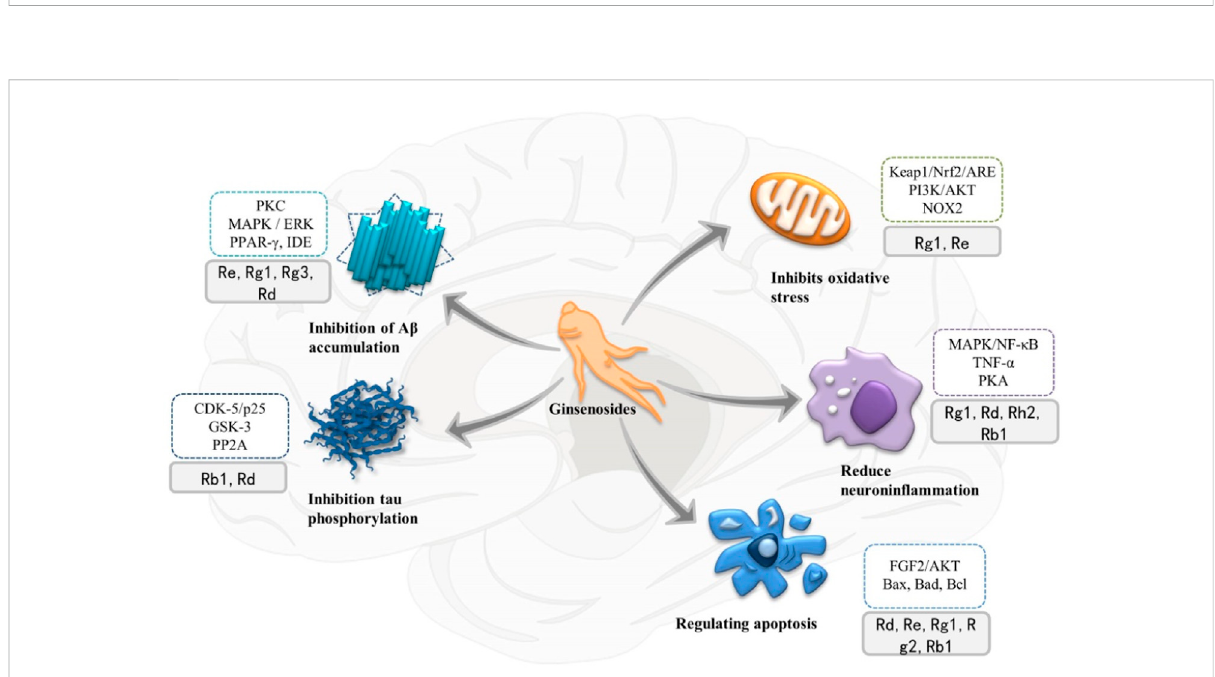
FIGURE 3 Multiple therapeutic targets of ginsenosides on Alzheimer ’ s disease (AD) and related signaling pathways and proteins involved. PKC, protein kinaseC;MAPK,mitogen-activatedproteinkinase;ERK,extracellularsignal-regulatedkinase;PPAR- γ ,peroxisomeproliferator-activatedreceptor- γ ; IDE, insulin-degrading enzymes; CDK-5, cyclin-dependent kinase-5; GSK3, glycogen synthase kinase 3; PP2A, protein phosphatase-2A; mTOR, mechanizedtargetsof rapamycin;NF- κ B, nuclearfactorKappa B;PKA,proteinkinase A;TNF- α ,Tumornecrosis factor α ;PI3K, phosphoinositol 3